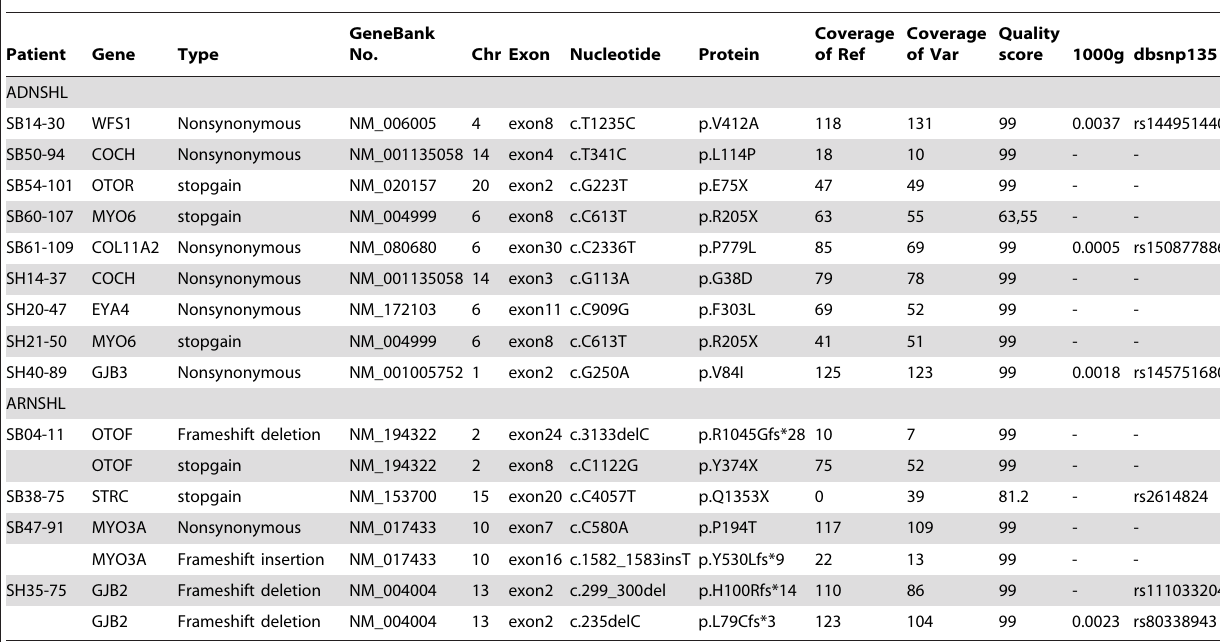
Table 3. List of final candidate SNVs in 13 familial